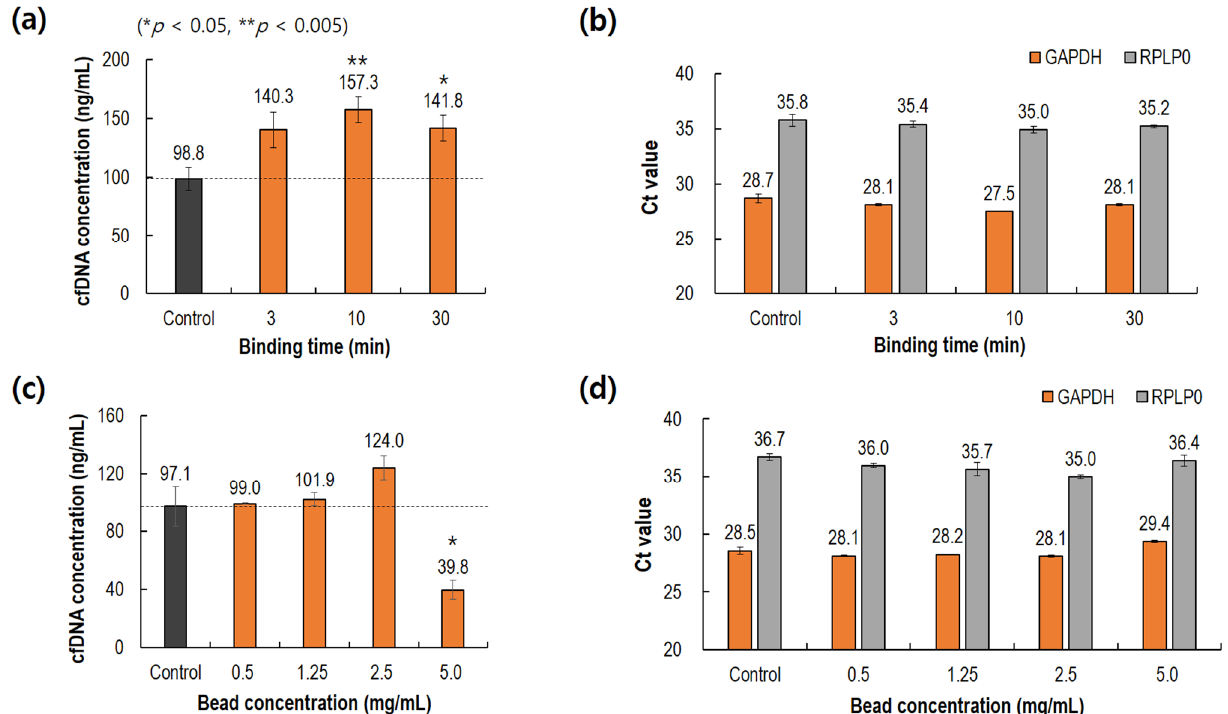
Figure 4. Comparison of cfDNA extraction with varying binding time and bead concentration. ( a ) Effect of binding time on cfDNA recovery. ( b ) Effect of binding time on cycle threshold of PCR. ( c ) Effect of bead concentration on cfDNA recovery. ( d ) Effect of bead concentration on cycle threshold of PCR. Control: QIAamp (Qiagen).